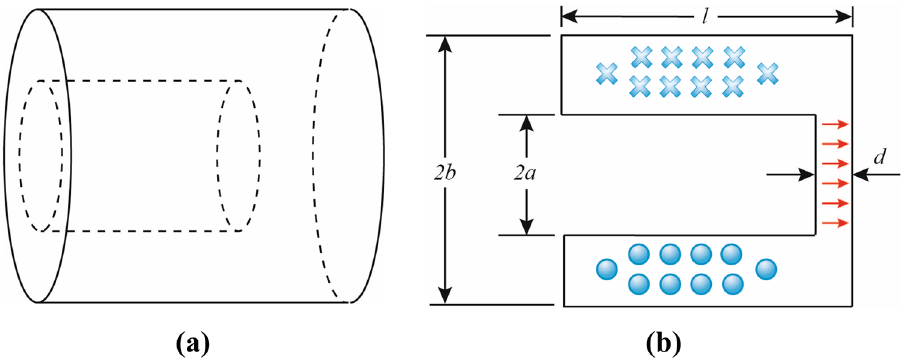
Figure 1. A cylindrical re-entrant cavity resonator with key structural dimensions; ( a ) Cavity structure; ( b ) Key dimensions and field configuration for TE 111 mode (crosses: inward H-field, circles: outward H-field, arrows: